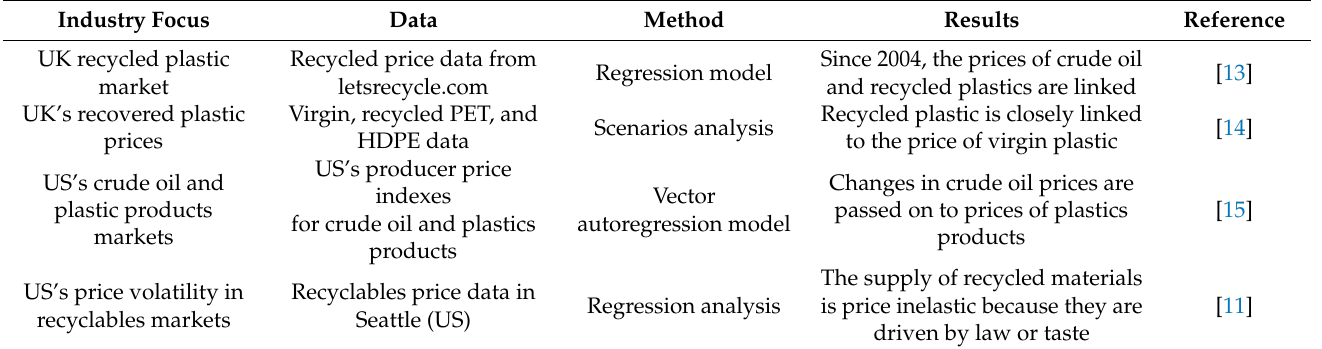
Table 1. Literature review on oil and primary and secondary plastic products prices relations.